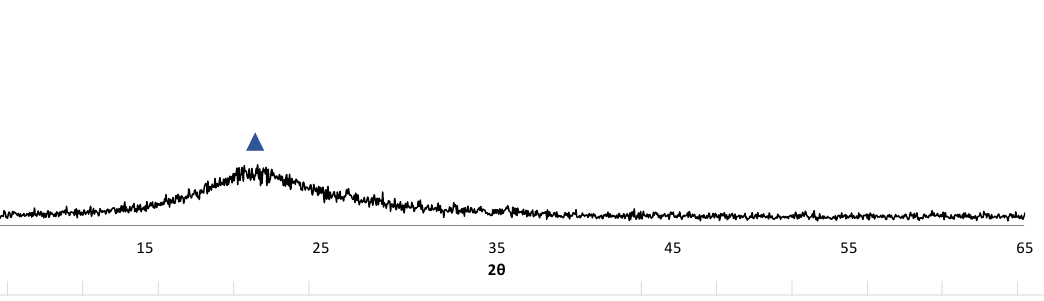
Figure 4. XRD pattern of SF.